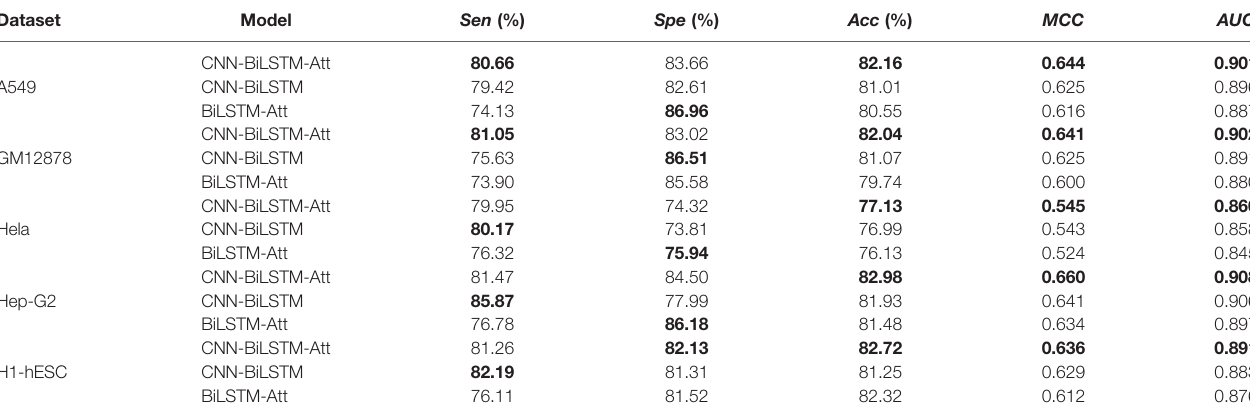
TABLE 1 | Performance comparison of CNN-BiLSTM, BiLSTM-Attention, and CNN-BiLSTM-Att with OneHot embedding. Dataset